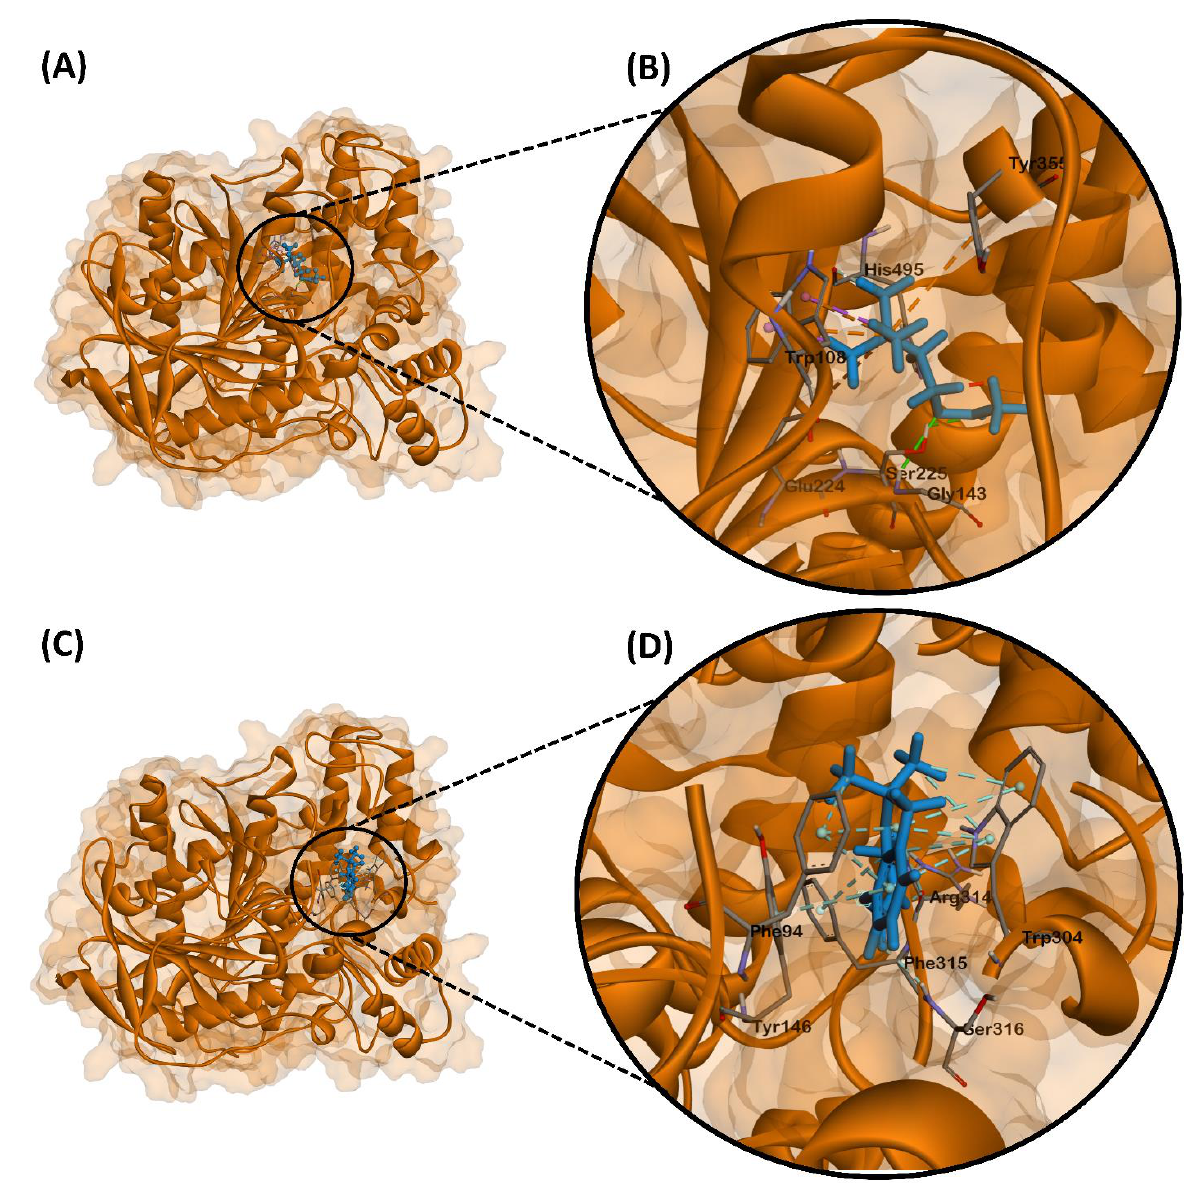
Figure 9. Molecular docking poses comparing the binding mechanism of ACh and carbofuran to AChE chain A. ( A ) Full view of the ACh-AChE complex, ( B ) expanded view of ACh’s binding site with interacting residues, ( C ) full view of the carbofuran-AChE complex, ( D ) expanded view of carbofuran’s binding site with interacting residues.